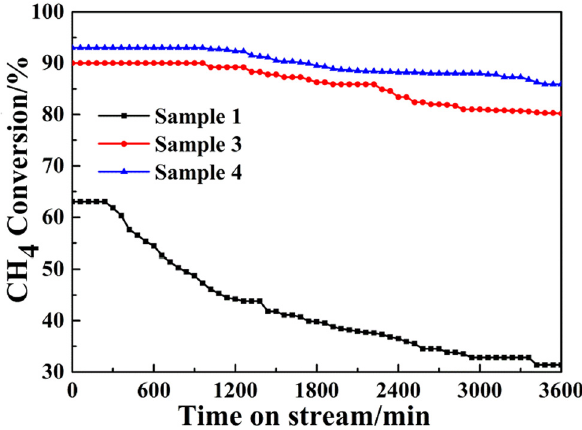
Figure 9: H 2 - TPR diagrams before and after the calcination of mine tailings.